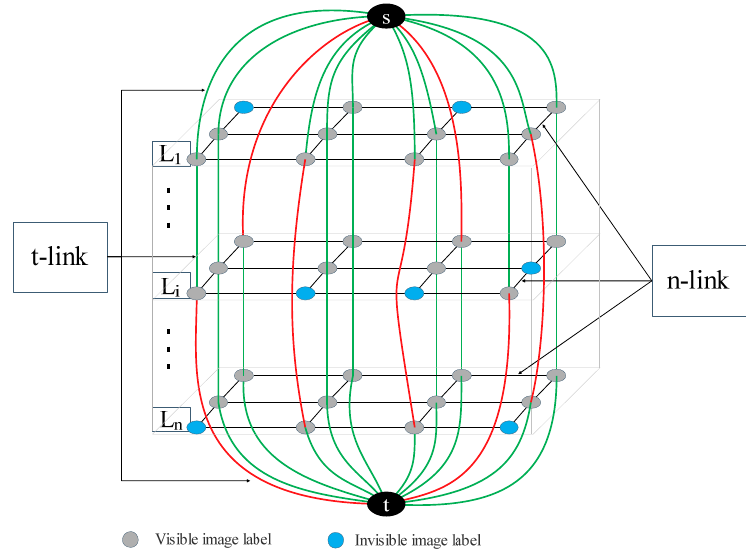
Figure 8. Multi ‐ labeled directed graph. Figure 8. Multi-labeled directed